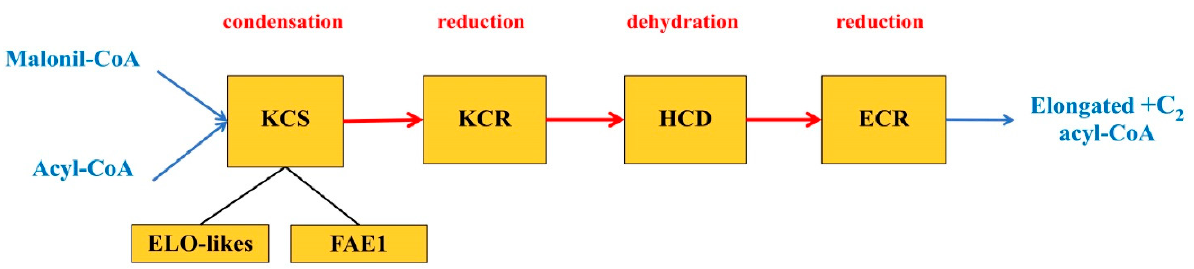
Figure 3. Enzymes of the VLCFA elongase complex. The elongation of VLCFA in the endoplasmic reticulum (ER) is carried out by an elongase complex that consists of four